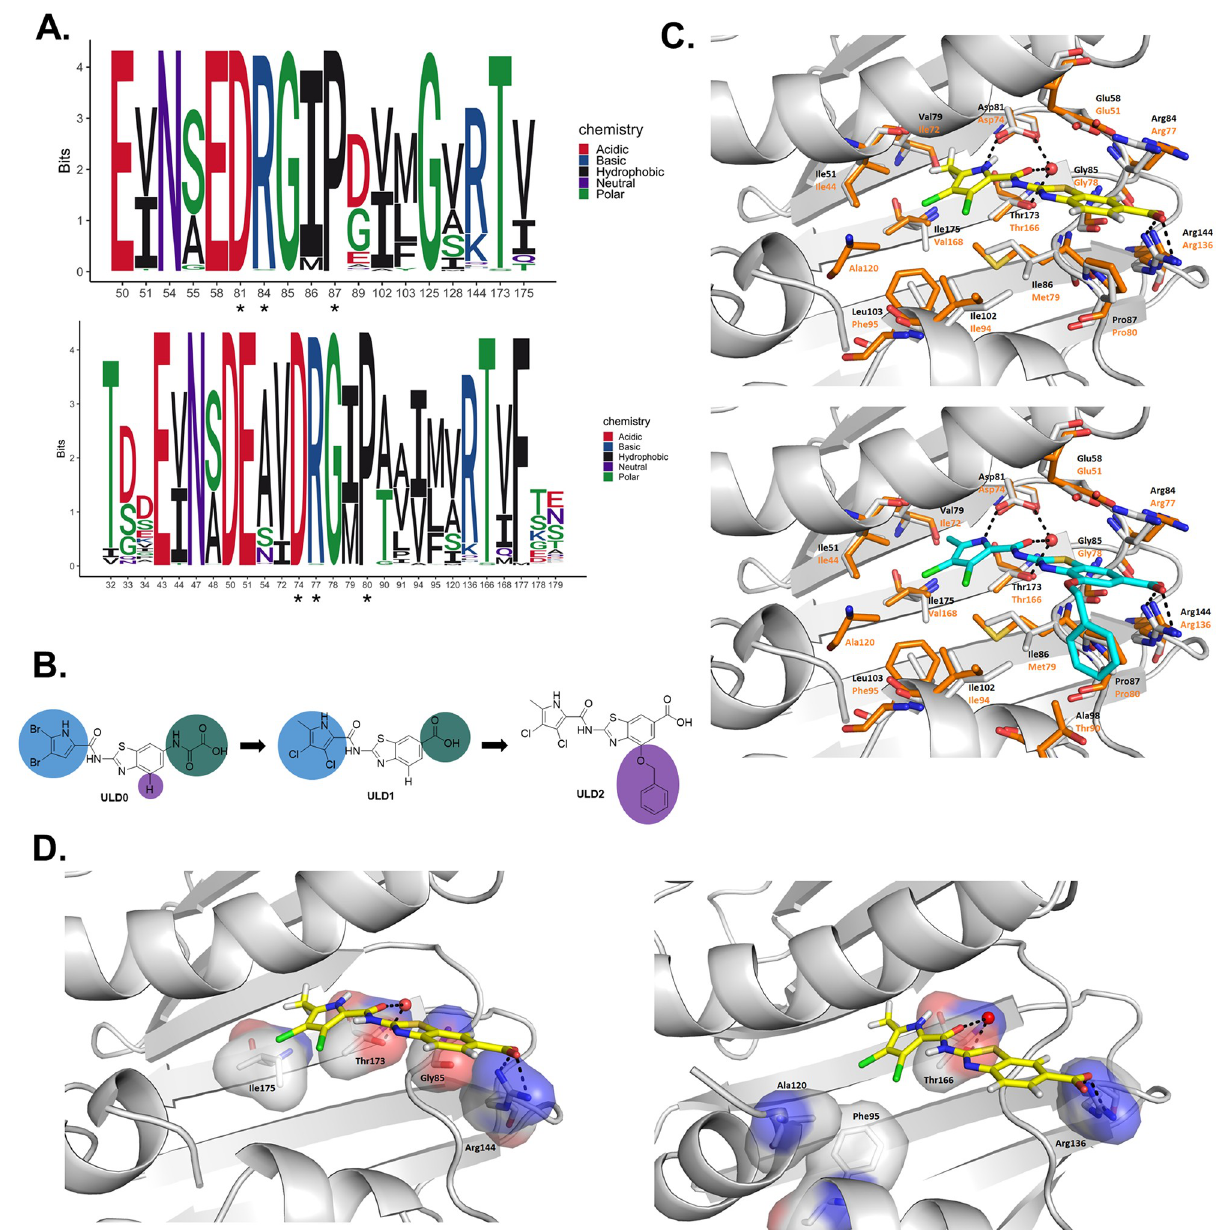
Fig 1. Rational design of antibacterial compounds, ULD1 and ULD2. We rationally designed antibacterial compounds, ULD1 and ULD2, that establish intermolecular interactions with Asp81/Asp74, Arg84/Arg77, and Pro87/Pro80 of S . aureus GyrB/ParE, respectively. A. Amino acid positions that are indicated by an asterisk are phylogenetically more conserved than others in the ATP-binding sites of DNA gyrase subunit B (GyrB, upper panel) and topoisomerase IV subunit E (ParE, lower panel) (Welch t -test, P < 0.0017 and P < 0.00001, respectively). The sequence logo depicts the diversity of the aligned sequences: The relative sizes of the letters indicate their frequency in the sequences. The total height of the letters depicts the information content of the position, in bits. B. Rational design of ULD1 and ULD2 as DNA GyrB and ParE dual-inhibitors. The green, blue, and purple circles indicate the terminal carboxylic acid moiety, the pyrrole moiety, and the benzyloxy substituent at position 4 of the benzothiazole ring, respectively, which were modified to obtain ULD1 and ULD2. C. The interaction pattern of ULD1 (in yellow, top) and ULD2 (in cyan, bottom) within the ATP-binding site of S . aureus GyrB and ParE. GyrB and ParE amino acids are indicated in black and orange (with sticks), respectively. PDB codes: GyrB (3TTZ), ParE (4URN). D. The location of spontaneous ULD1 resistance-conferring mutations within the ULD1 binding pocket of GyrB (left panel) and ParE (right panel), respectively. Resistance-conferring mutations were identified based on targeted single-molecule real-time sequencing of the drug targets following a standard frequency-of-resistance assay, and the identified mutations were subsequently plotted on the tertiary structure of the target proteins. Atom-type coloring: blue for N, red for O, gray for C. GyrB, subunit B of DNA gyrase; ParE, subunit E of topoisomerase IV.